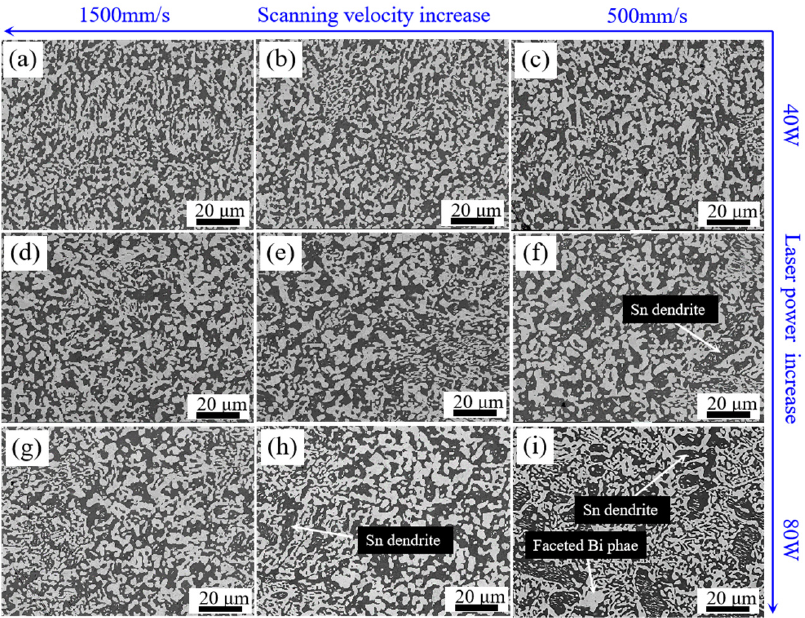
Figure 4. BSE images of Sn58Bi alloy specimens fabricated by LBPBF with different parameters: ( a – c ) 40 W with 1500, 1000 and 500 mm/s, respectively, ( d – f ) 60 W with 1500, 1000 and 500 mm/s, respectively, ( g – i ) 80 W with 1500, 1000 and 500 mm/s, respectively.